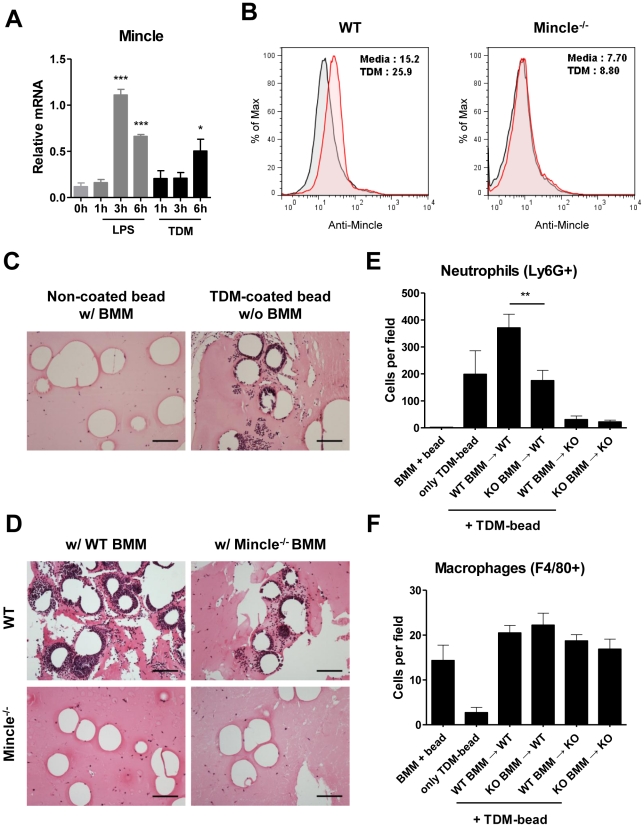
Neutrophils were recruited to TDM-coated-beads by recognition of TDM through Mincle.(A) Bone marrow (BM) neutrophils from C57BL/6 mice were stimulated with 10 ng/ml LPS or 25 µg/ml trehalose dimycolate (TDM). Mincle mRNA expression was measured by quantitative RT-PCR and normalized to Hprt mRNA levels. Significantly different levels from 0 h are indicated. *p<0.05 and ***p<0.001. (B) Mincle surface expression was determined by flow cytometry. BM neutrophils from WT and Mincle−/− mice were stimulated with 25 µg/ml TDM for 18 h and analyzed by flow cytometry. See also Figure S1. (C–D) Matrices were injected into mice (s.c.) and harvested after 20 h. Formaldehyde-fixed paraffin-embedded sections were Hematoxylin and eosin stained. (C) Matrices contained non-coated beads with C57BL/6 bone marrow macrophages (BMMs) (left panel) or TDM-coated beads without BMMs (right panel). (D) Matrices containing TDM-coated beads were injected into wild-type (WT, upper panels) or Mincle−/− (KO, lower panels) mice with WT BMMs (left panels) or Mincle−/− BMMs (right panels). Photomicrographs are representative regions from each section. Scale bars represent 100 µm. (E–F) Ly6G+ neutrophils (E) or F4/80+ macrophages (F) adjacent to TDM-coated beads were counted from at least five randomly-selected fields from each stained section. Statistical significance: **p<0.01. Data are representative of at least three independent experiments.